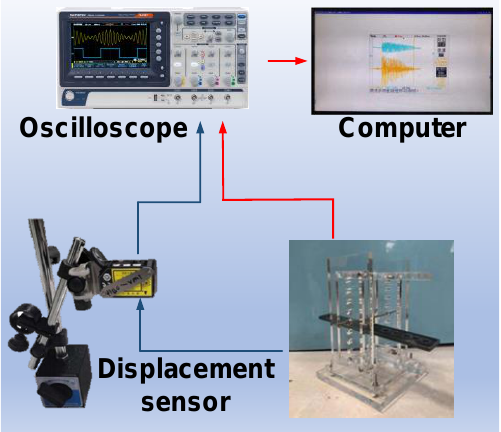
Figure 5. The experimental setup for beam evaluation.